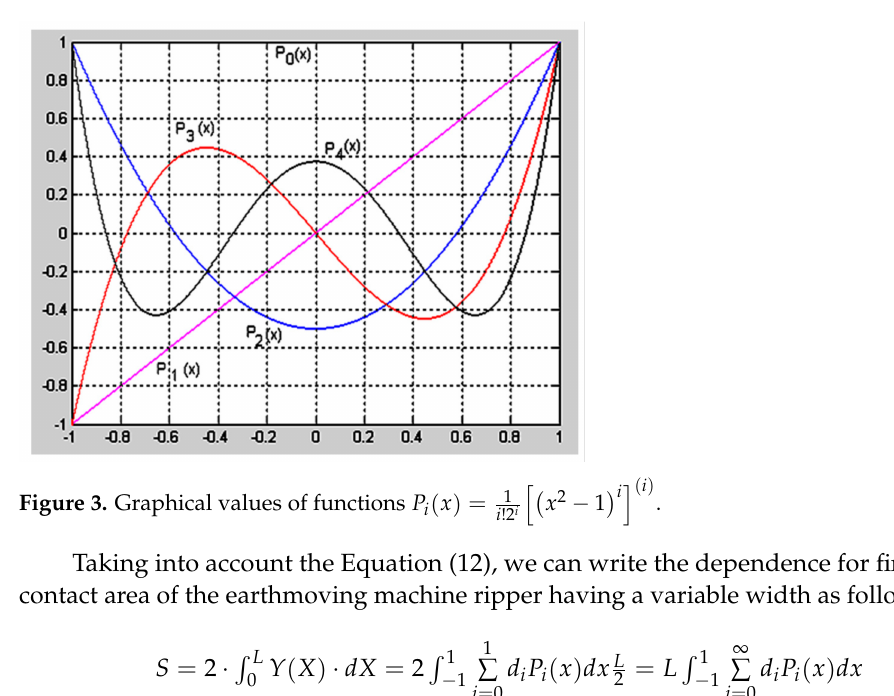
(cid:104)(cid:0) (cid:1) i (cid:105) ( i ) x 2 − 1 i !2 i